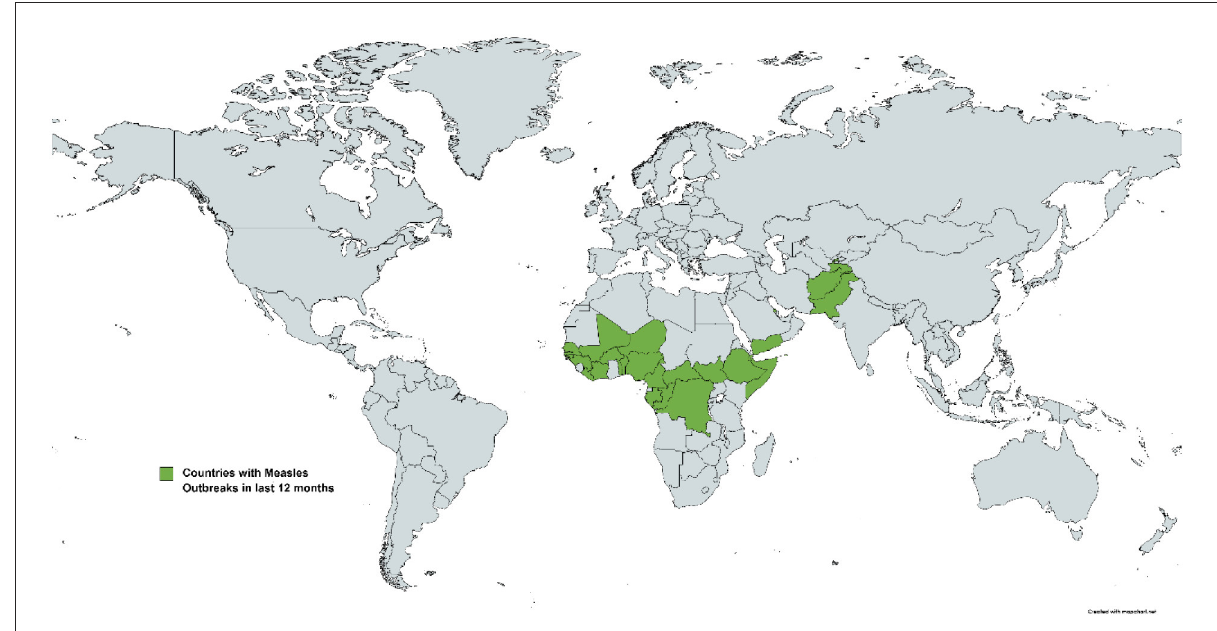
FIGURE1 Countries with large measles outbreaks in the past 12